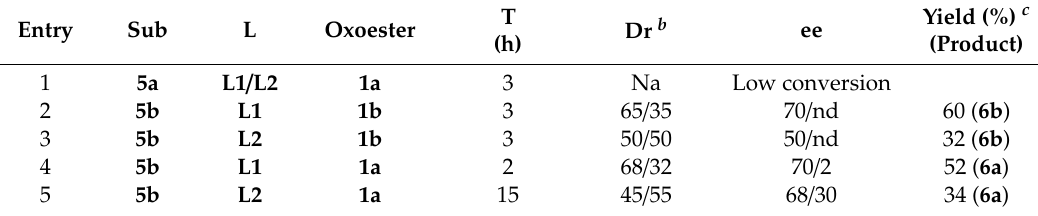
Table 2. Results of N -acyl Mannich reaction of oxoesters 1a,b with N,O -acetals 5a,b. a.